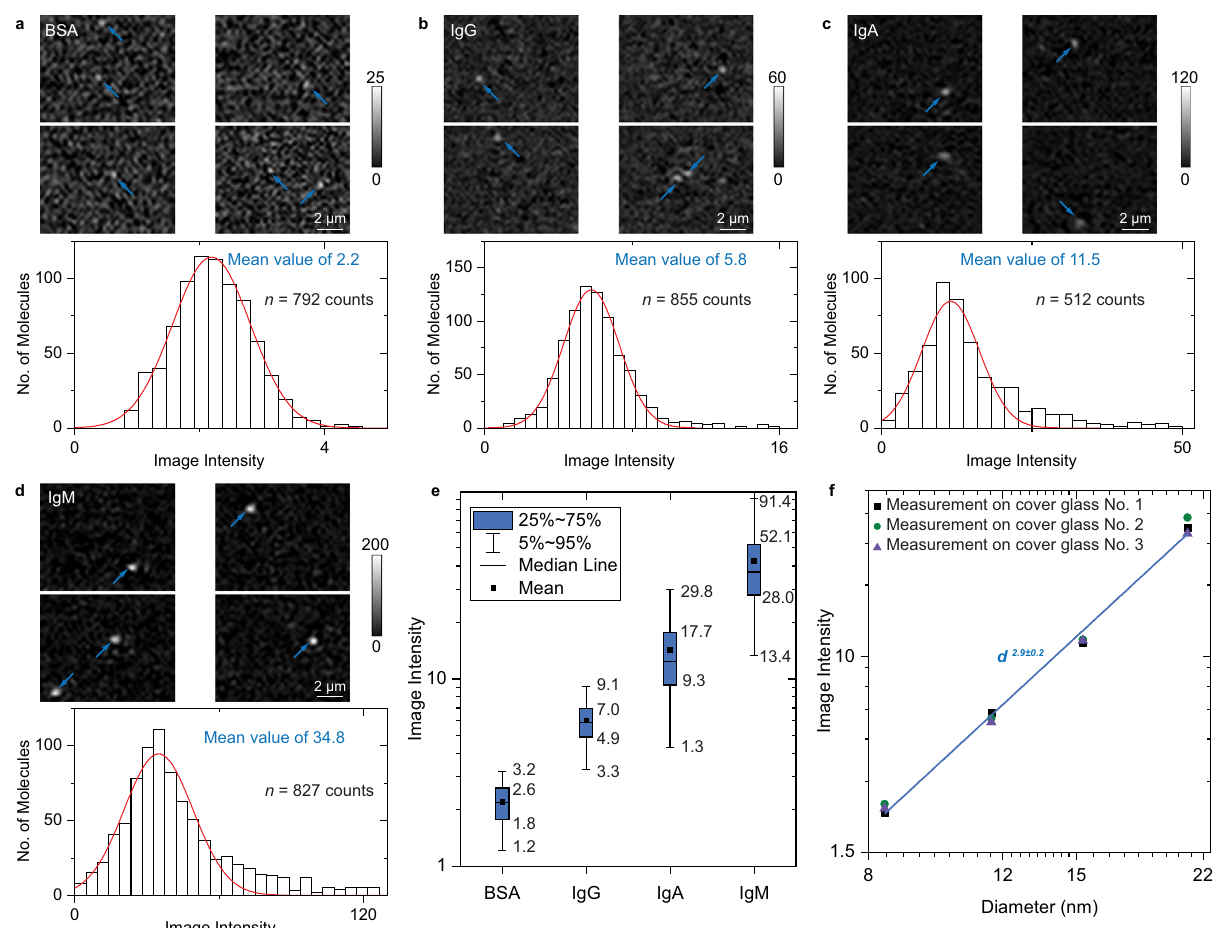
Fig. 2 Imaging single proteins with ESM. a – d ESM images and image intensity histograms of BSA ( a ), IgG ( b ), IgA ( c ), and IgM ( d ) proteins, where the solid red curves are Gaussian fi ttings. Individual proteins are marked with arrows. Incident wavelength: 450 nm. Incident intensity: 60 kW cm − 2 . Camera exposure time: 5 ms. The ESM images of BSA, IgG, and IgA were achieved by subtracting the previous frame from each frame after averaging the raw images with a period of 50 ms. The ESM images of IgM were achieved by subtracting the previous frame from each frame without averaging. The sample sizes and mean values of the histograms are presented in each panel. e Box plots of image intensities measured on different proteins from ( a – d ). The sample sizes are presented in a-d, and the counts come from biologically independent molecules. The minima, maxima, and center values are 0.8, 4.4, and 2.2 for BSA, 1.1, 16.0, and 5.9 for IgG, 1.1, 50.0, and 12.4 for IgA, and 1.8, 148.9, and 37.1 for IgM, respectively. The bounds of box and whiskers are presented in the fi gure. The percentile is de fi ned by mean value, which is 2.2 for BSA, 6.0 for IgG, 14.3 for IgA, and 42.7 for IgM, respectively. f ESM image intensity versus protein diameter measured by dynamic light scattering in logarithmic scale, where the z-distance dependence of evanescent wave is considered (Supplementary Note 1). The image intensities for each diameter were obtained from the peak values of the corresponding histograms for measurement on each of the three cover glasses. The histograms obtained from the measurements on different cover glasses can be found in Supplementary Fig. 10. The experiments were repeated three times with similar results for ( a – d ). fi tting the histograms with Gaussian distribution. Reproducible results were obtained for each protein in three different chips (Supplementary Fig. 10). Plotting the image intensity versus protein diameter in logarithmic scale reveals that the ESM image intensity responds to the protein diameter in a cubic power, because the interference term, 2| E || E |cos ( θ ) in equation (1), is dominant for single protein imaging (Fig. 2f). We compared the image intensities of proteins with polystyrene nanoparticles (Supplementary Note 2), which fall on a similar calibration curve, further supporting the results of single proteins imaging on ESM.